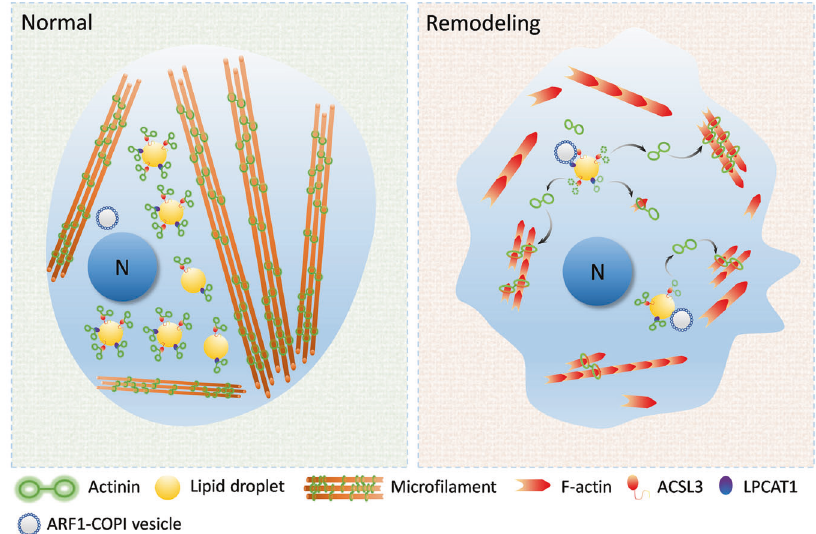
Fig. 8 The schematic diagram of LDs modulating micro fi lament remodeling. Cellular LDs in myoblast can recruit actinins through the LD- related proteins ACSL3 and LPCAT1. When the cellular micro fi laments remodeling (e.g., migration, fusion) which promoted contact between LDs and ARF1-COPI vesicles. Meanwhile, the recruited actinins are released from maternal LDs. Thereafter, the released actinins from the LDs were involved the polymerization and remodeling of micro fi laments. LDs contribute the process of cellular micro fi laments